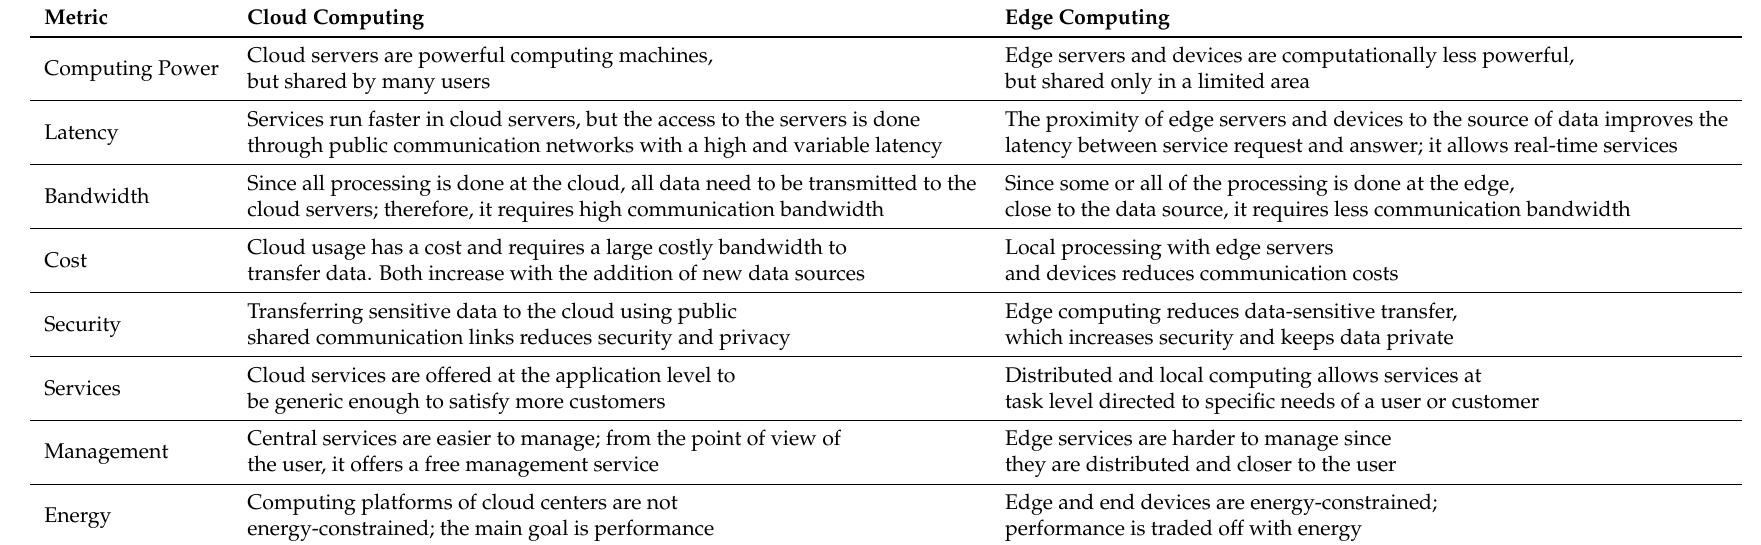
Table 1. Comparison of cloud computing versus edge